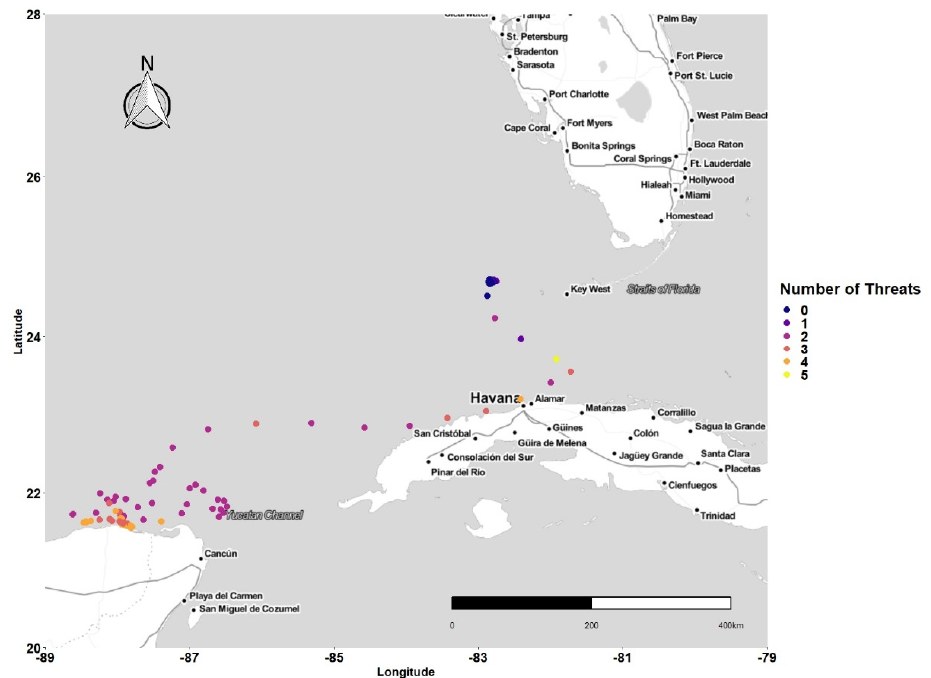
Figure A1. State-space model (SSM) points of Turtle #3, a green turtle ( Chelonia mydas ) that migrated from Dry Tortugas National Park to the Yucatan Peninsula between 13 April and 13 July 2019. Each color represents the number of unique high threat categories encountered on that given day within a 2 km buffer of the SSM point. Note that tracking data stops before this turtle returned.